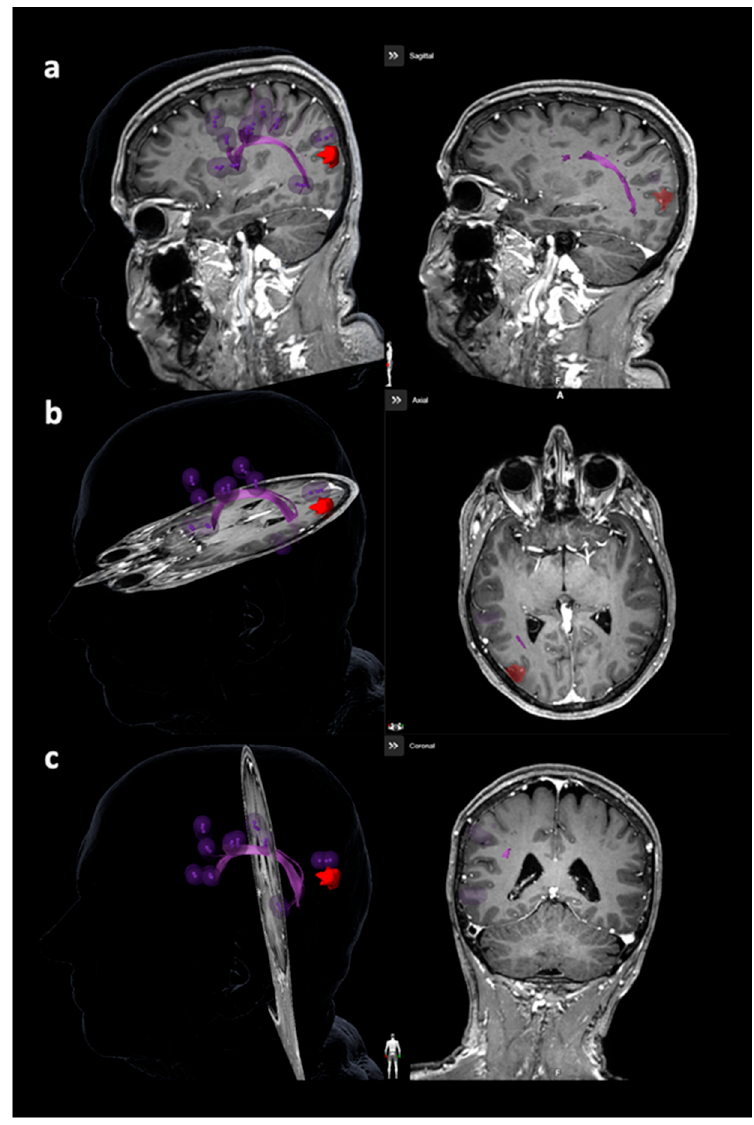
Figure 2. Visualization of the arcuate fascicle (AF). This figure depicts the AF in purple considering all planes (( a ): sagittal plane, ( b ): axial plane, ( c ): coronal plane), with the reconstruction being purely based on diffusion tensor imaging fiber tracking (DTI FT) using the language map derived from navigated transcranial magnetic stimulation (nTMS). The language map is represented by purple spots, while the tumor volume is enclosed in red.